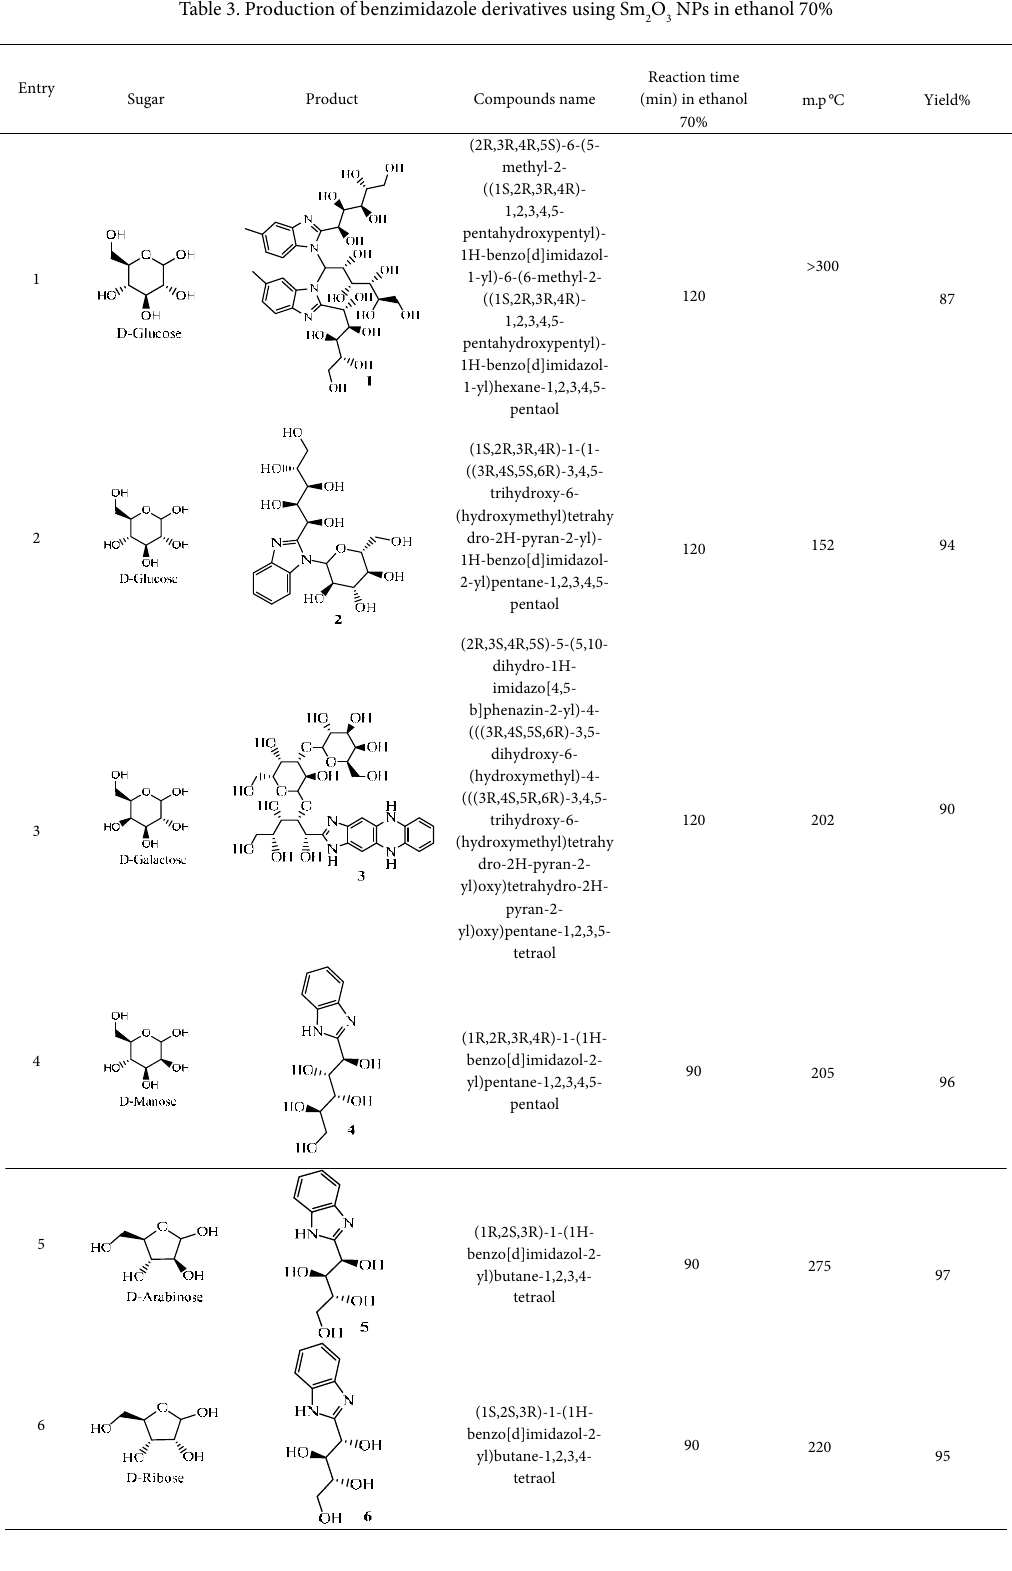
Table 3. Production of benzimidazole derivatives using Sm 2 O 3 NPs in ethanol 70%